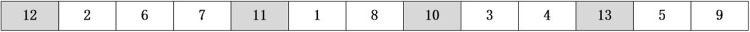
Situation 1 of dead solutions.